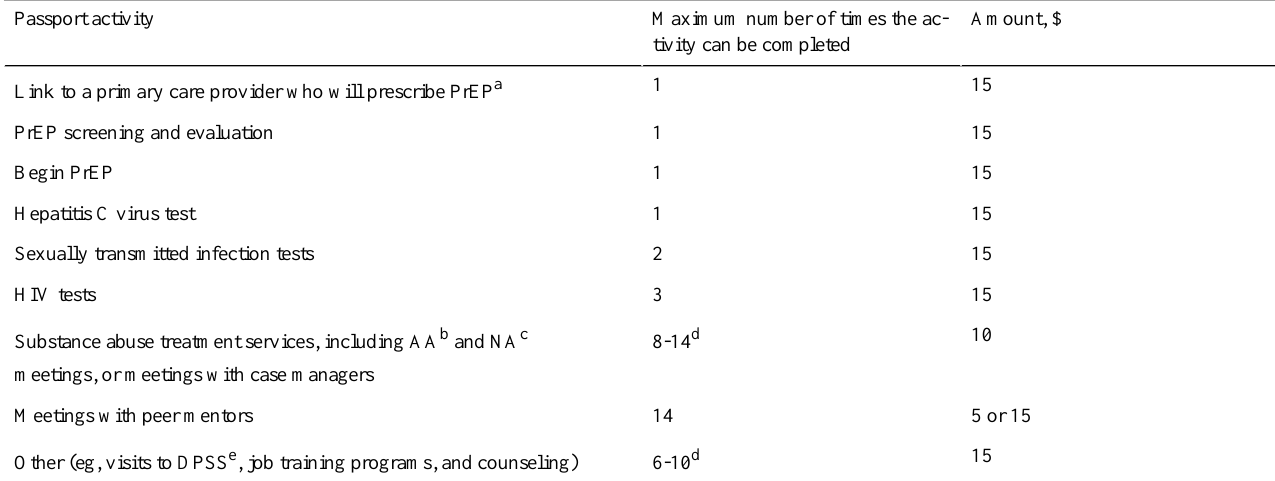
Table 1. Incentive schedule.